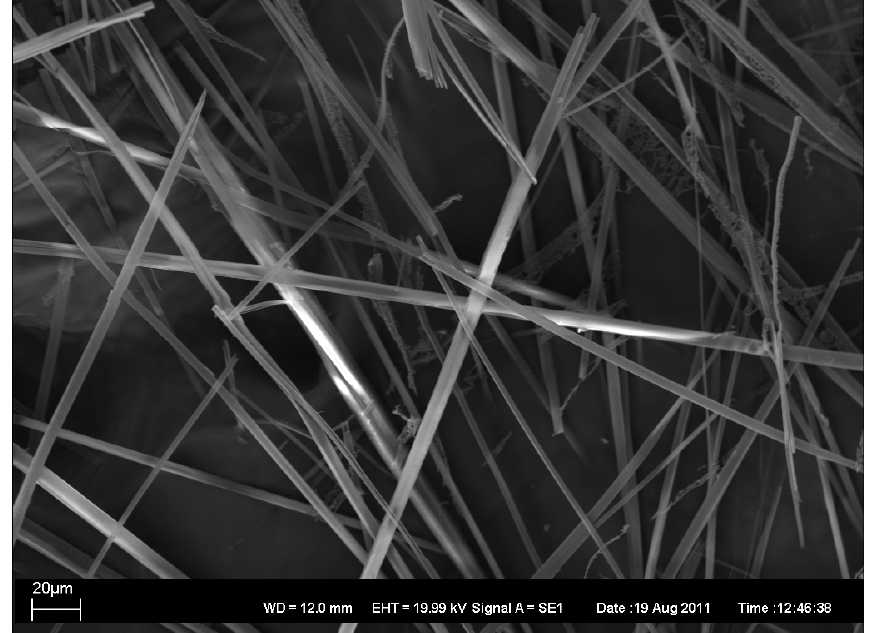
Figure 4. SEM image of xerogel from 1:1 1-PrOH/water 2%